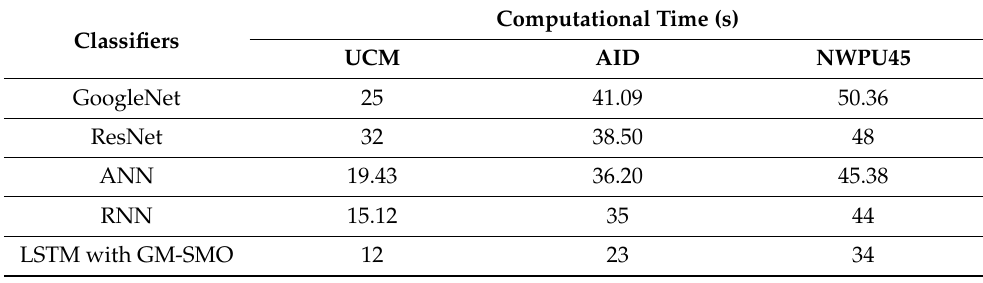
Table 4. Results of the GM-SMO with LSTM classifier in terms of means of computational time.